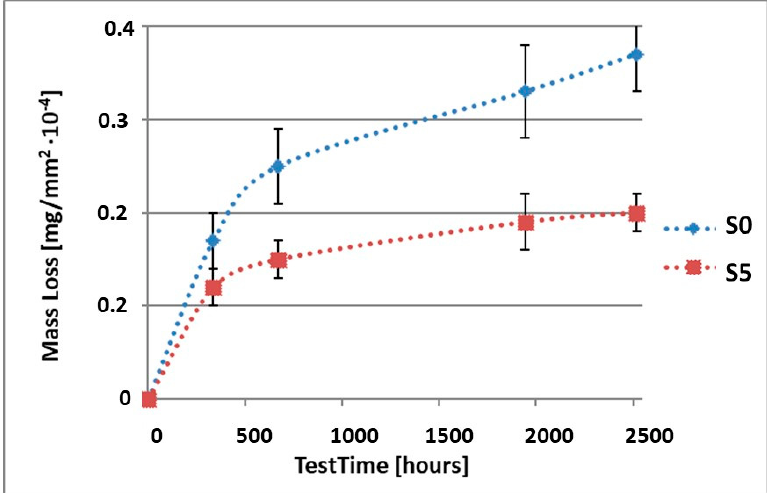
Figure 4. Comparison of the mass losses of samples S0 and S4 for tests in NSS environment.